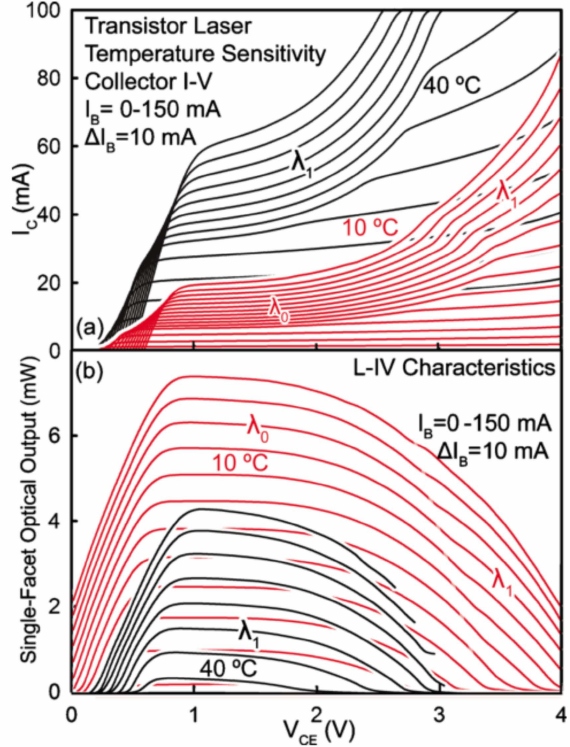
Figure 7. ( a ) TL collector I-V characteristics curve at various temperatures. When the temperature rises, the I-V characteristics curve rises and compresses in the negative direction of V CE , which is the same as the increase in the power gain (I B ) of V CE , and the corresponding optical gain decreases. ( b ) TL collector L-IV characteristics curve at various temperatures. The single-facet optical power varies with temperature, the power decreases at high temperature, and the main excitation energy level changes [44]. Reproduced from Ref. [44], with the permission of AIP